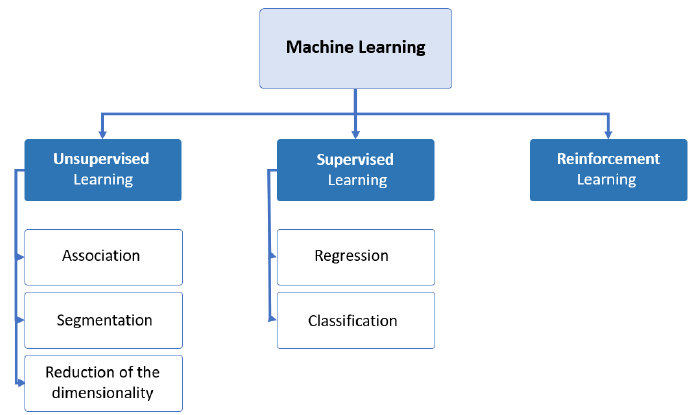
Figure 5. Machine learning classifications [13]. Supervised learning is used in most practical ML applications. An algorithm known as supervised learning begins with a training dataset that contains both the input and output variables [14]. The matching function between the input and the output is learned using an algorithm. To predict the output variables using new input data, it is necessary to approximate the matching function. Regression and classification problems are two categories of supervised learning issues. Unsupervised learning has no corresponding output variables, only input data. Problems with clustering and feature extraction can be classified as unsupervised learning problems